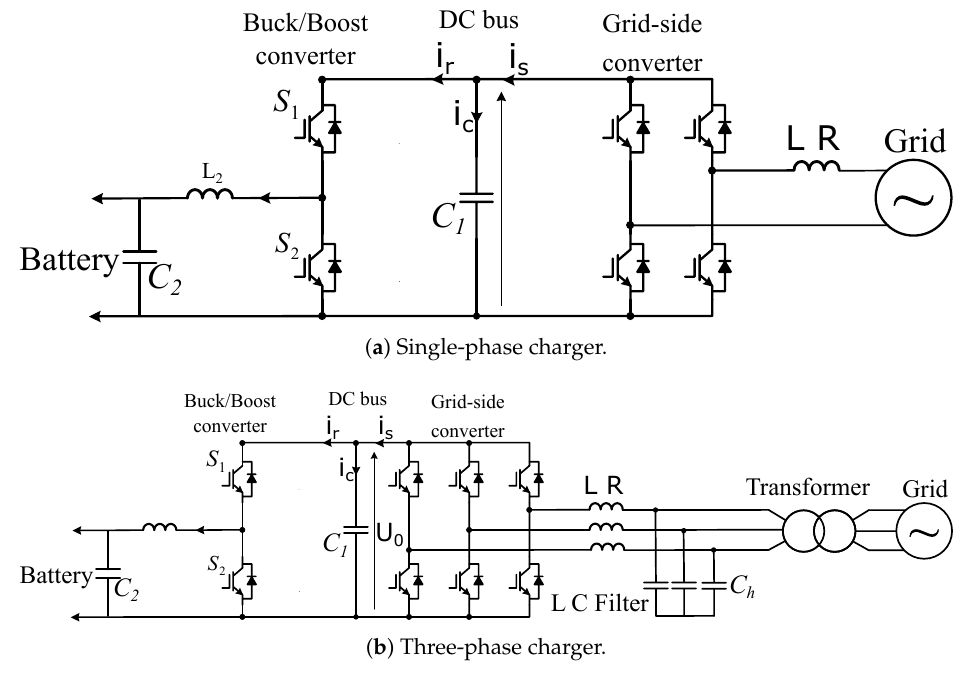
Figure 12. Bidirectional battery charger for